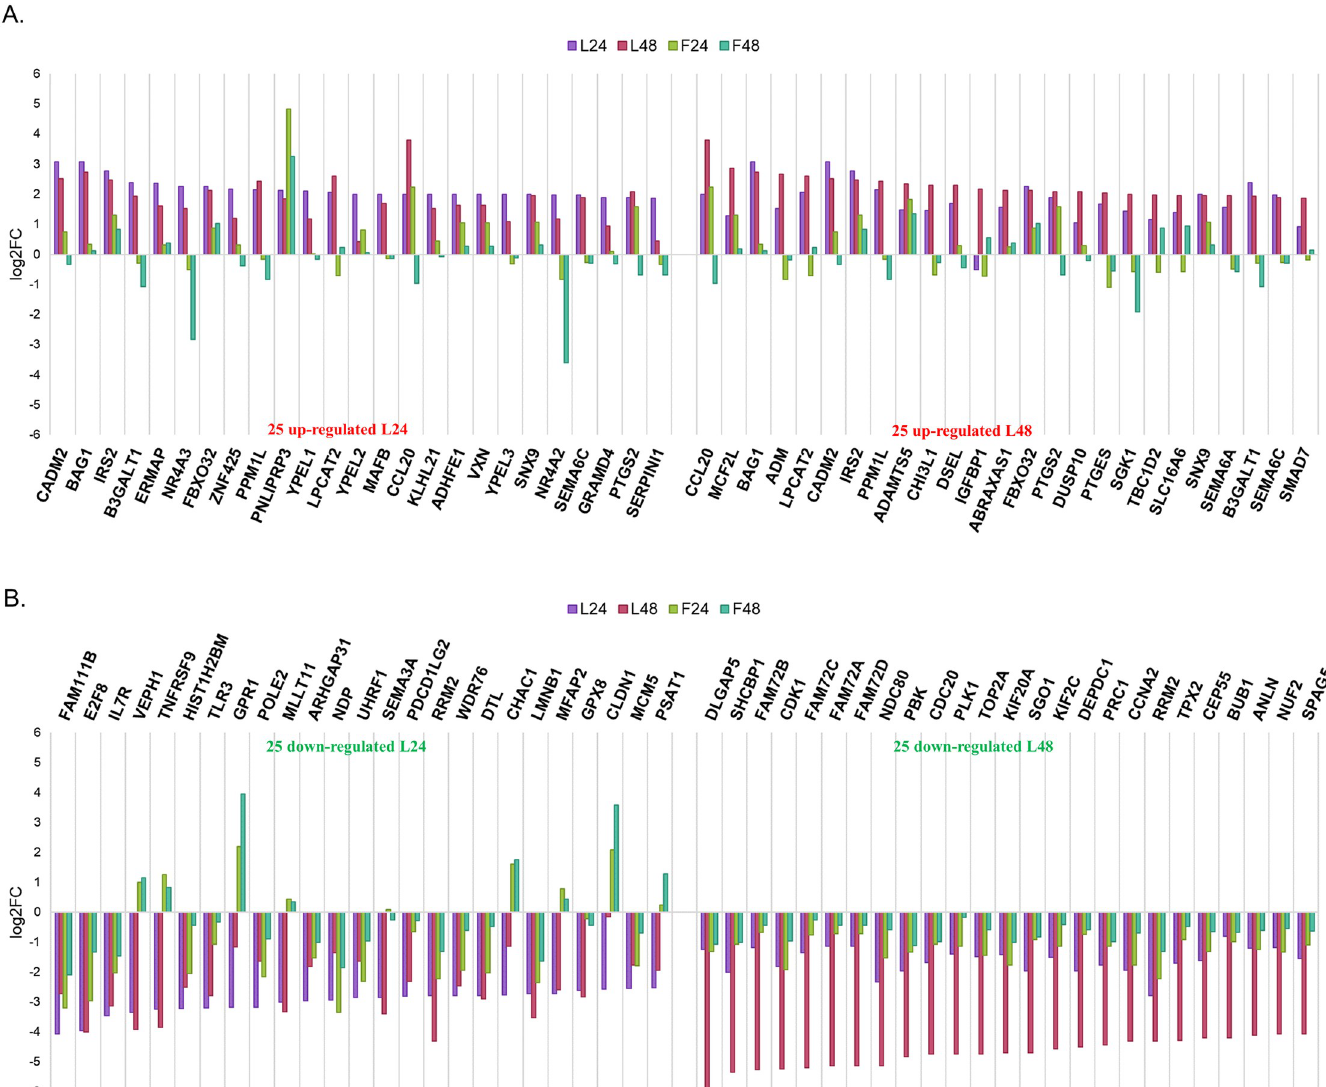
Fig 4. Gene expression signature difference between conditions using the 25 most differentially expressed up-regulated (A) and down-regulated (B) genes after LY- 294002 at 24h (left side) and 48h (right side) treatment. The expression of an individual gene (log2FC) across all four conditions is marked in specific colors per condition (F24—light green, represents the expression of a gene after 24h treatment with fucoxanthin; F48—dark green, represents the expression of a gene after 48h treatment with fucoxanthin; L24—mauve represents the expression of a gene after 24h treatment with LY-294002; L48—pink, represents the expression of a gene after 48h treatment with LY-294002). The response to LY-294002 is consistent over time.